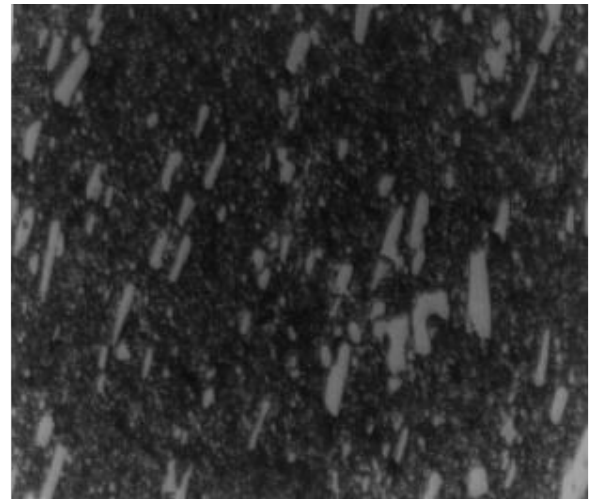
Figura 10. Antes do ensaio 1.